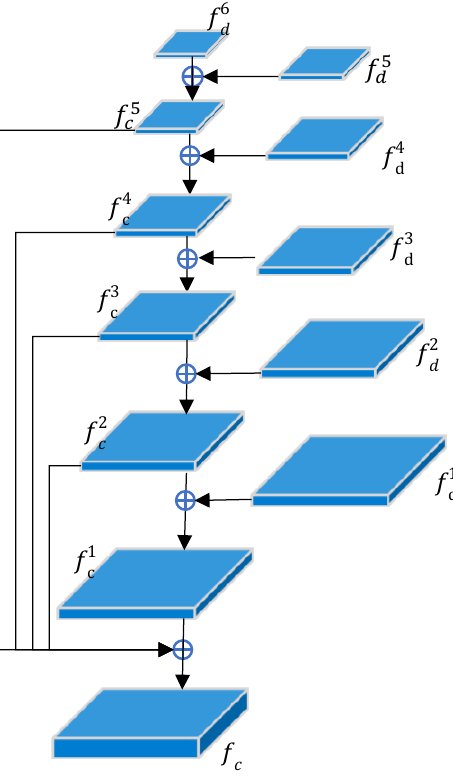
Figure 6. Pyramid change feature decoder.